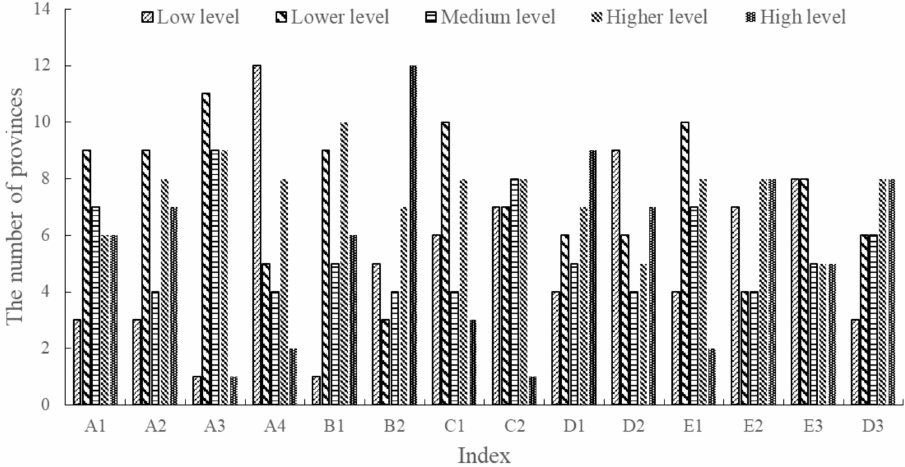
Figure 3. The number of provinces (regions, cities) at different levels of each